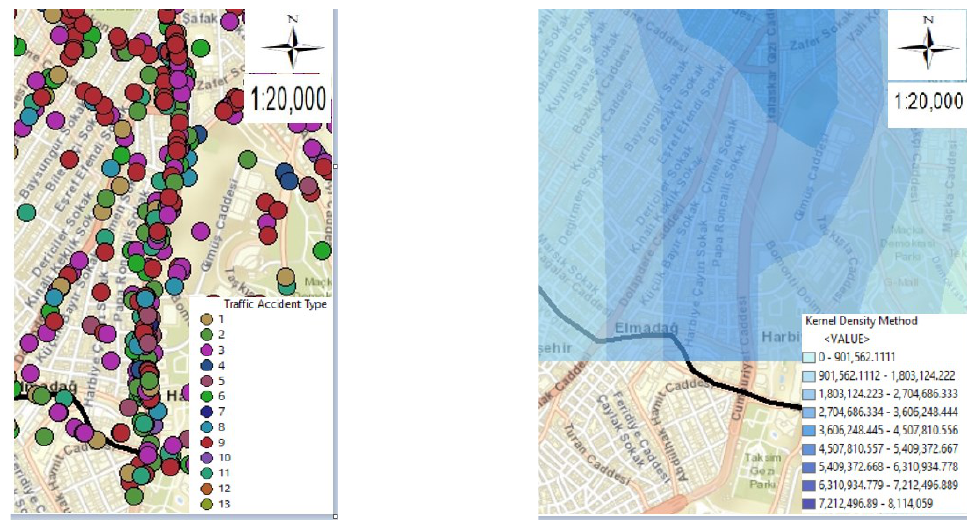
(b) Figure 12. Maps of traffic accidents on Cumhuriyet Street in Şişli district: (a) Thematic accident map by type of accident; (b) Kernel Density method map.